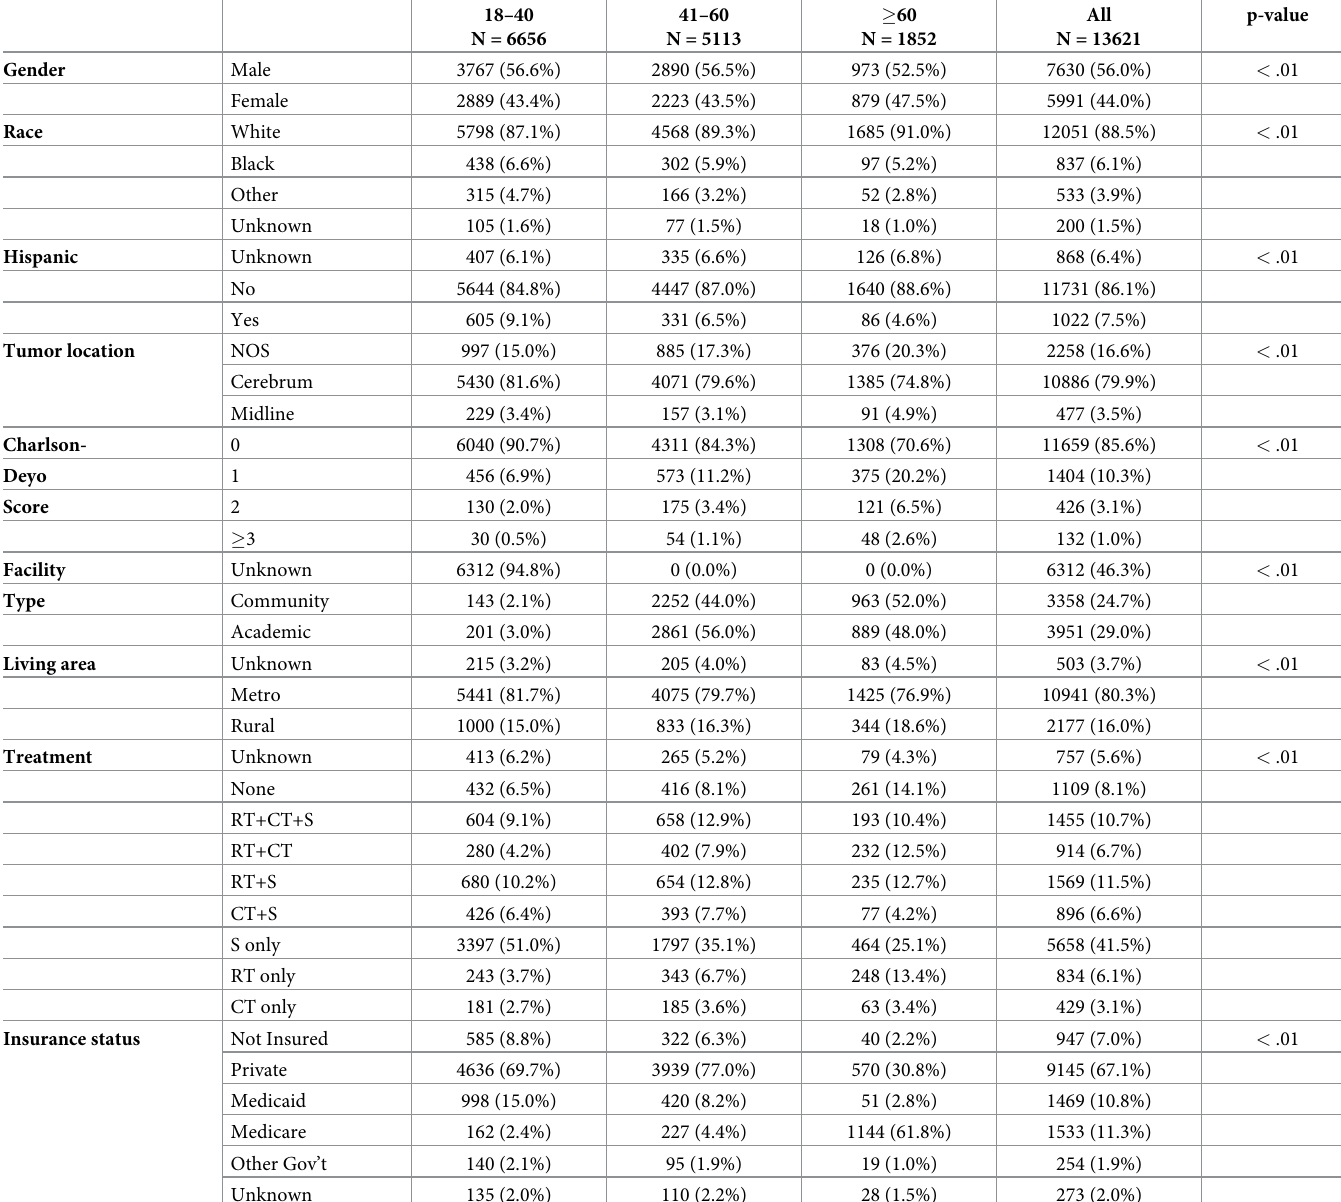
Table 1. Characteristics of the study population, by age